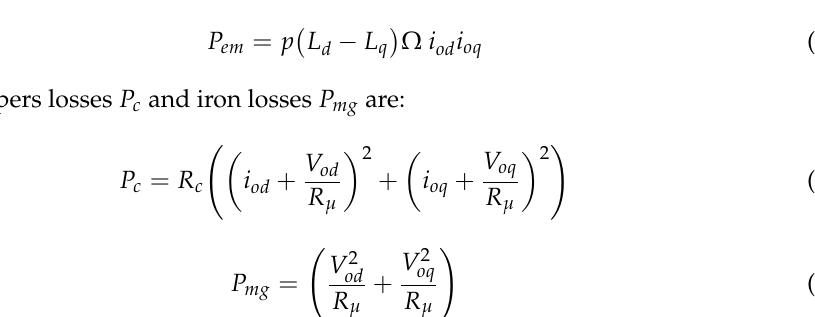
Figure 2. d ‐ q axis equivalents circuits.